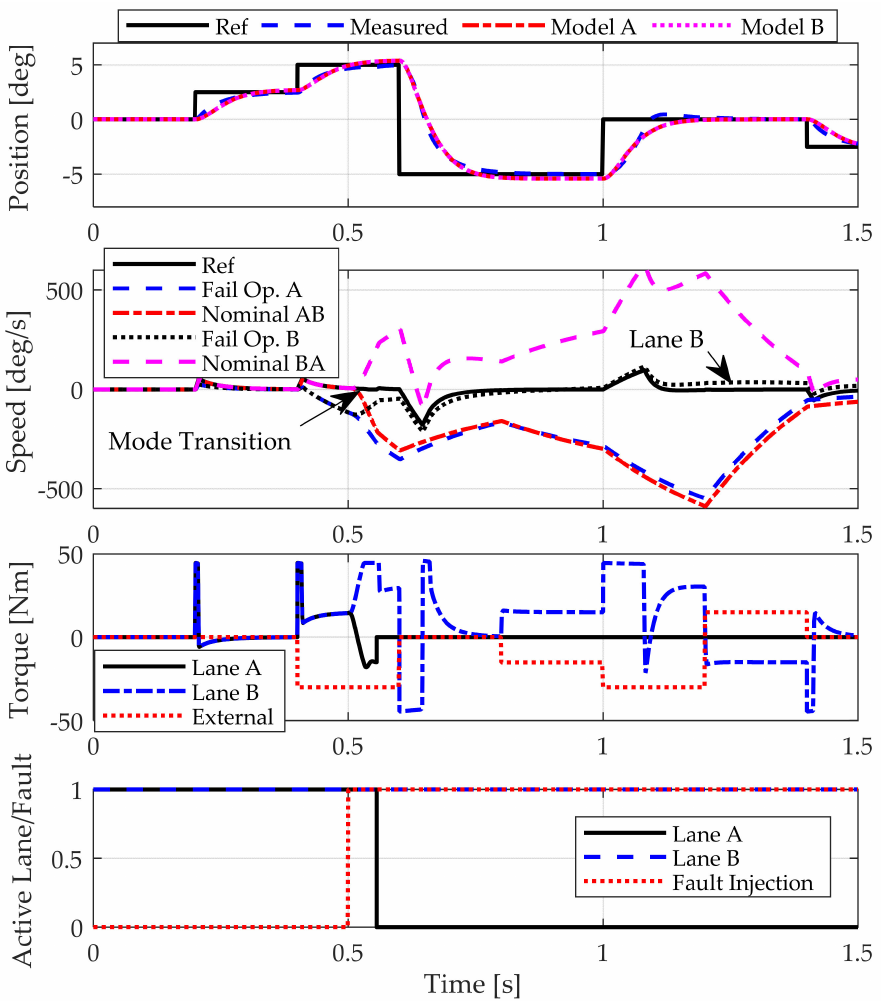
Figure 21. Example of a fail-operational after a local lane fault, fault ID = 18 in Table 3. The third case study is for fault ID = 16, where 80% reduction of the magnetic flux of Lane B occurred after 0.5 s, as shown in Figure 22. As described in Section 5.1.1, a reduction of the magnetic flux is a parameter-based fault injection by decreasing the magnetic flux parameter in the actuator model. The fault has been detected by a diversion from the reference speed to the speed of fail-operational B (ILM B ). This diversion initiated a mode transition after 0.082 s of injecting the fault. There is no significant deviation for the position tracking error after the fault